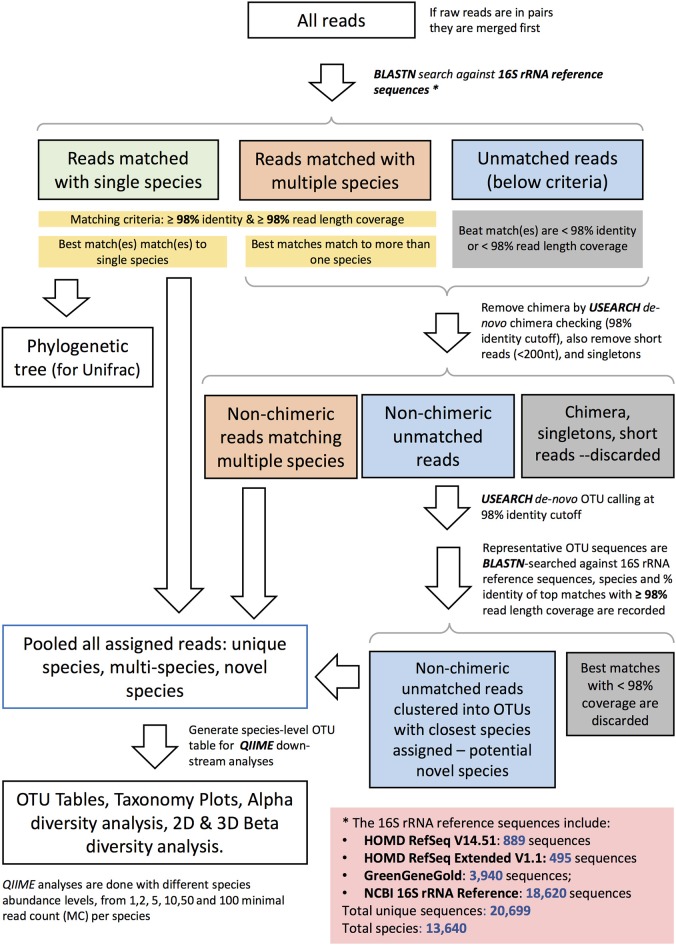
Schematic diagram representing the species–level open reference taxonomy assignment for 16S rRNA Reads.